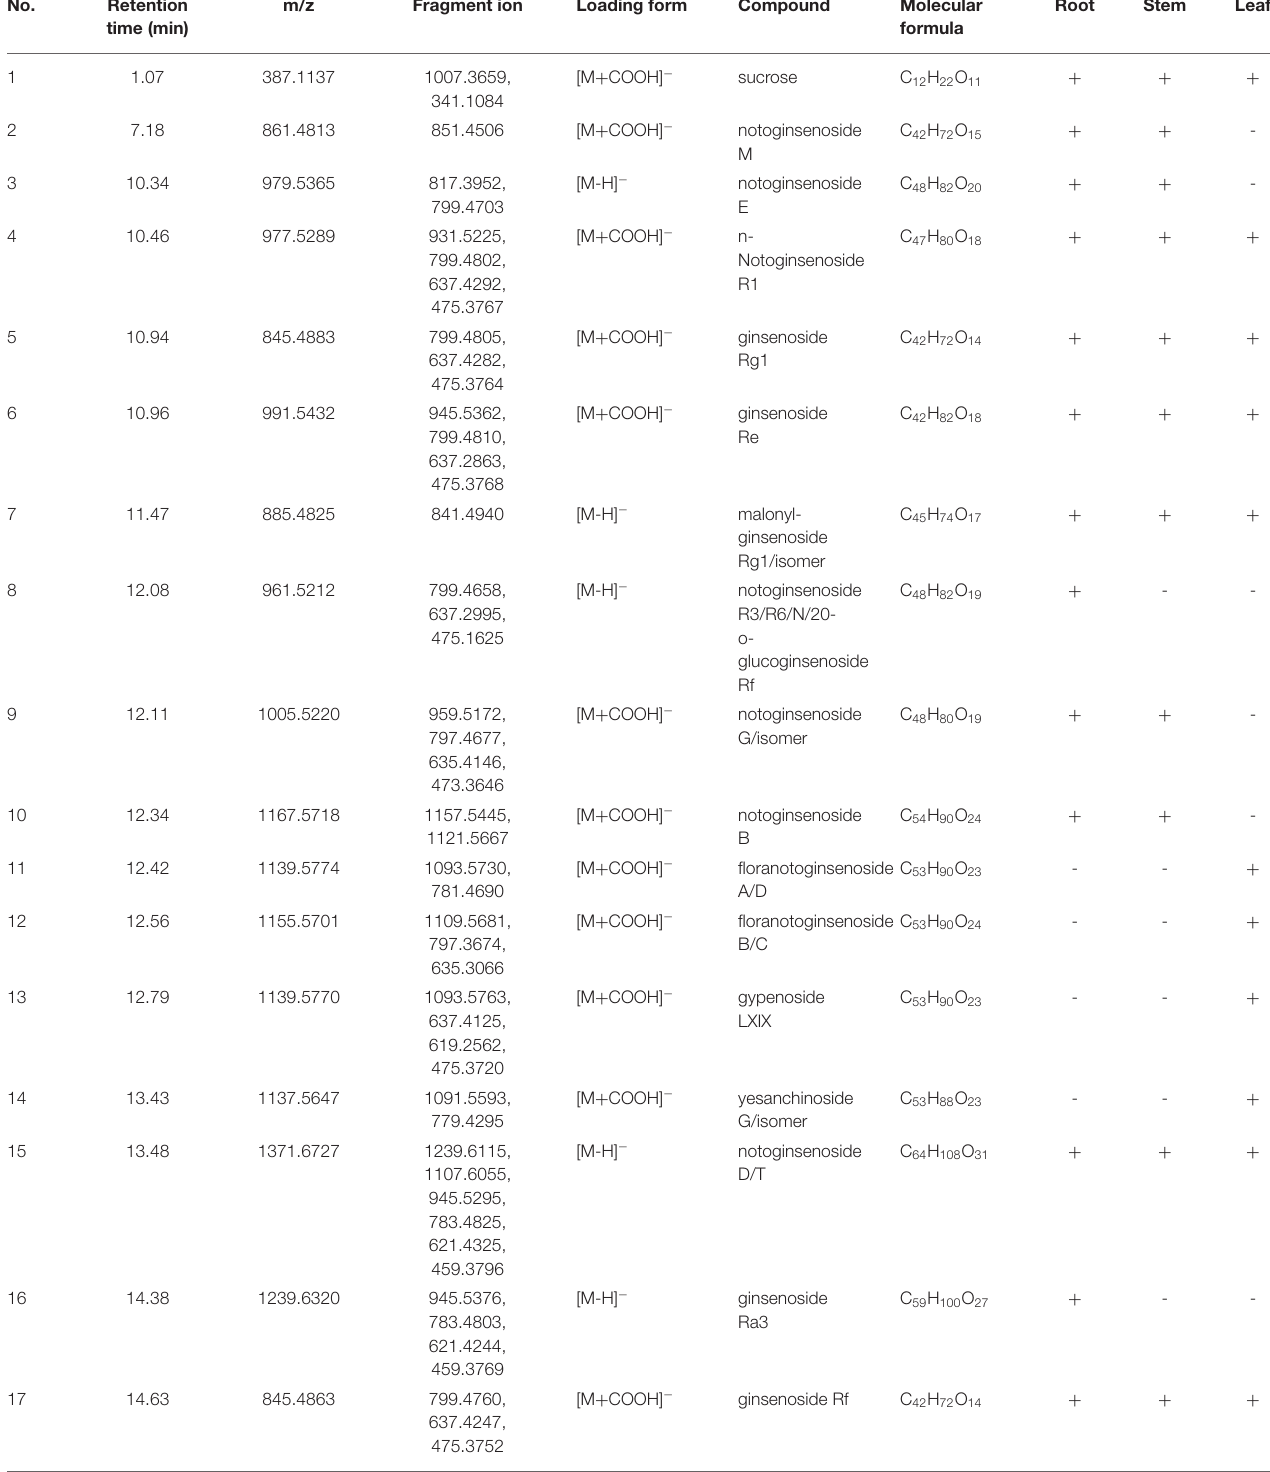
TABLE 2 | Possible non-volatile chemicals in root, stem and leaf of P. notoginseng under the mode of negative ions. No. Retention m/z Fragment ion Loading form Compound Molecular time (min)